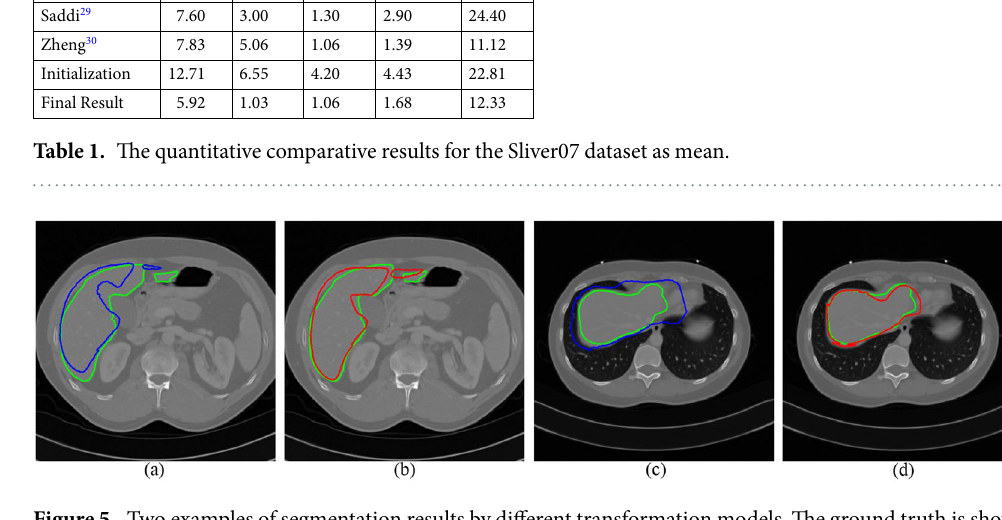
Figure 5. Two examples of segmentation results by different transformation models. The ground truth is shown in green curves. ( a ) and ( c ) Segmentation using the affine model (blue curves). ( b ) and ( d ) Segmentation using the FFD model (red curves).